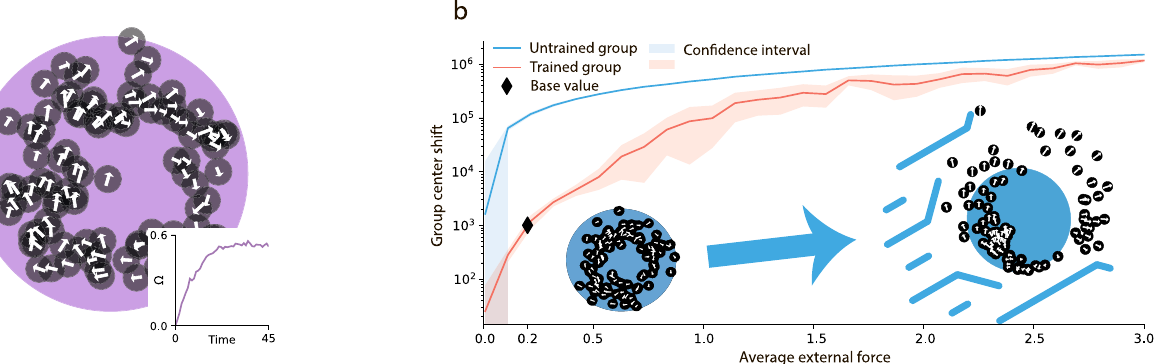
Figure 3. ( a ) Swirling in a swarm of 100 agents. The large violet circle describes the target distance to the group center, white arrows indicate the speed direction, and the small shaded circles are the agents’ comfort zones. The center of the swarm moves with a constant velocity. Inset: Time dependence of the average angular velocity (cid:31) of the swarm (see Sect. Methods for the definition). (cid:31) evolves from zero to non-zero steady-state value. ( b ) The dependence of the shift of a swarm center in the direction of the applied force as a function of the average external force. The results are shown for swarms trained for swirling and untrained swarms. The trained swarm (with swirling) can resist the external force up to 100 times more efficiently than the untrained one. The resistance of the trained swarm fades for very large external forces when they become comparable to the the maximal force that an agent can exert. The base value marker indicates the reference value of the average force used in